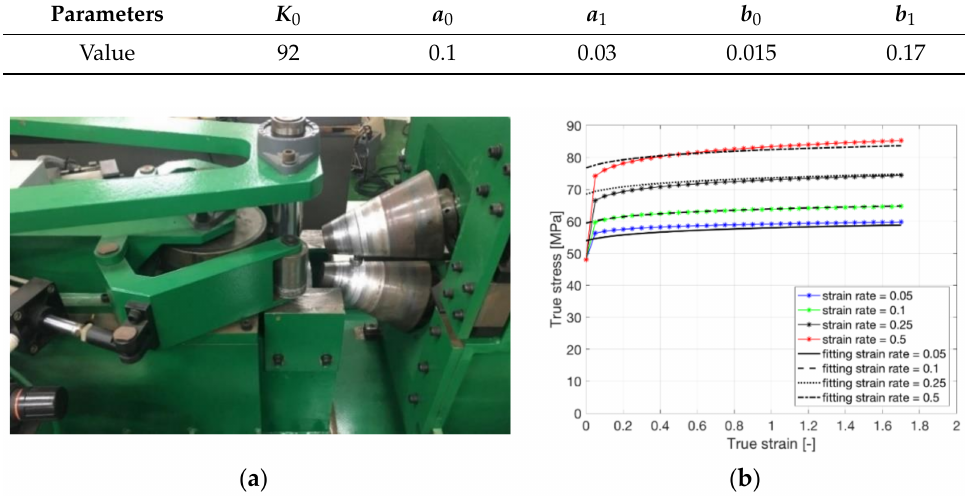
Figure A1. ( a ) Laboratory-size ring rolling machine utilized for the experiments and ( b ) Pb75-Sn25 alloy flow